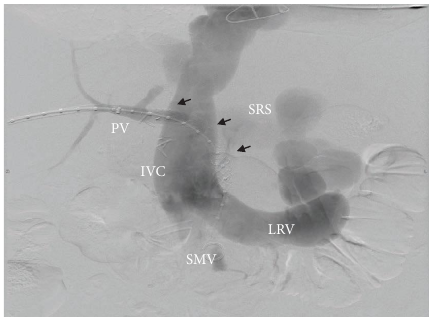
Figure 4: Newly established hepatopedal fow. Although, persistent high fow via the